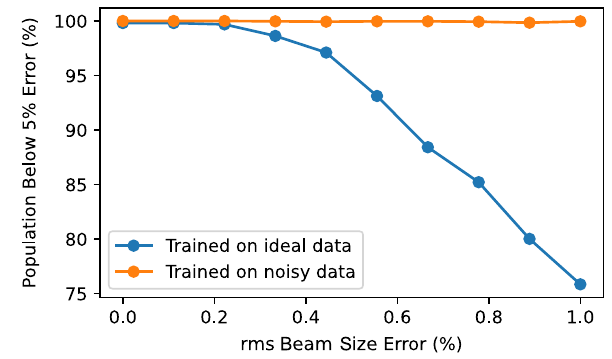
FIG. 8. Population with less than 5% prediction error on the emittance vs different artificial noise levels. The FCNN layout is the same in both shown cases. Note that in order to enable a direct comparison, the FCNNs used here were trained on the datasets with fixed scan range and constant spacing. This explains the generally better performance compared to Table